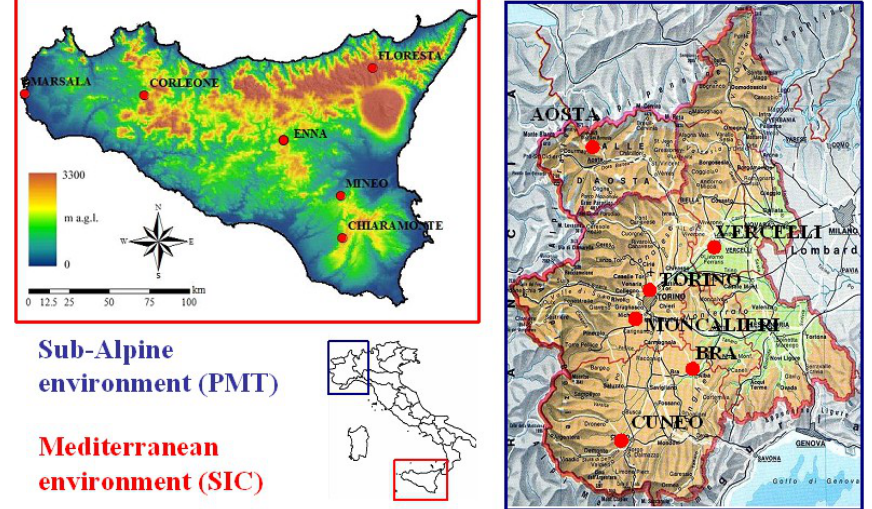
Figure 1. Spatial location of the rain gauges that provided rainfall time series used for the analysis. Left panel reports the 6 stations located in the Mediterranean area (SIC), whereas right panel reports the 6 stations located in the sub-Alpine (PMT) area.